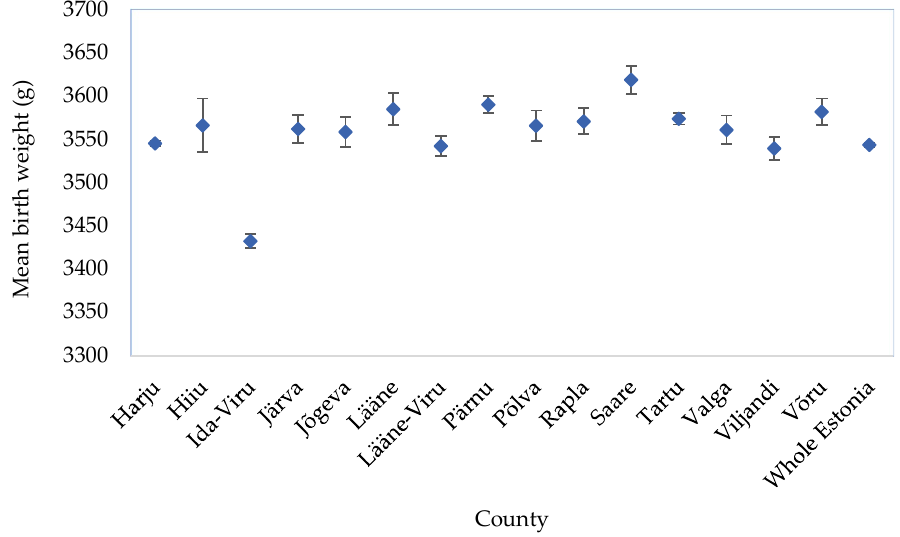
Figure 3. National and county–level average birth weight (grams) with a 95% confidence interval.